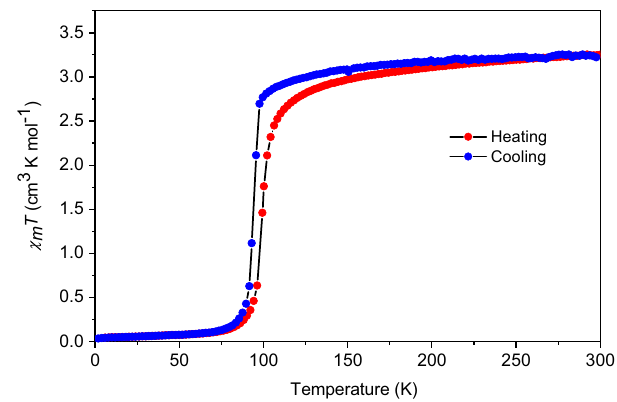
Fig. 2 Magnetic properties of the [FeCo] crystals. Temperature dependence of magnetic susceptibilities displayed as a plot of χ m T vs. Temperature. Data were collected on heating and cooling modes with a temperature sweep rate of 2.5 K min − 1 .